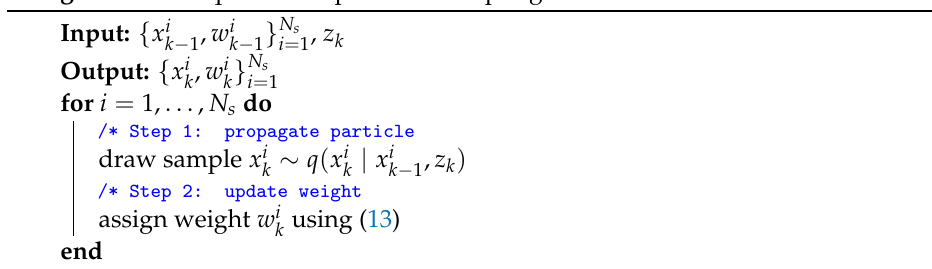
Algorithm 1: Sequential Importance